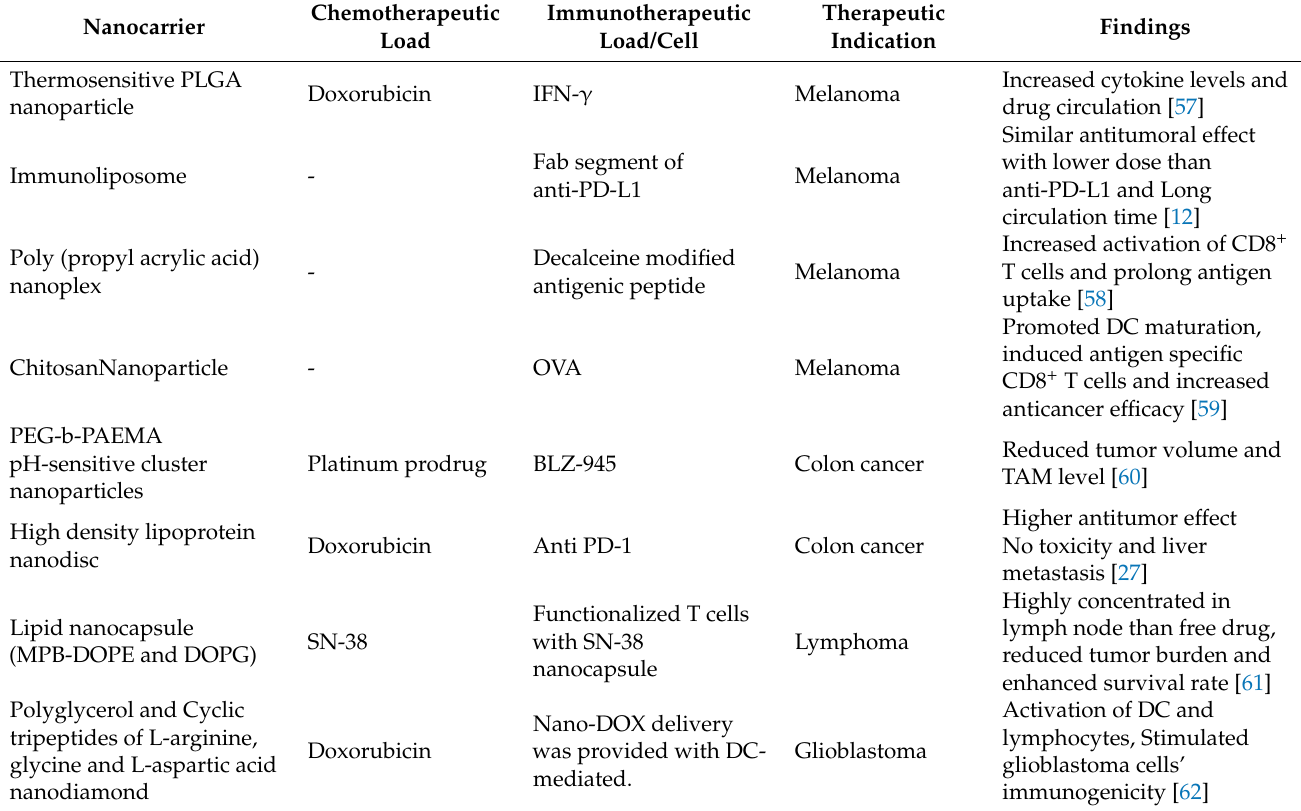
Table 3. Summary of several nanoparticulate drug delivery systems on cancer